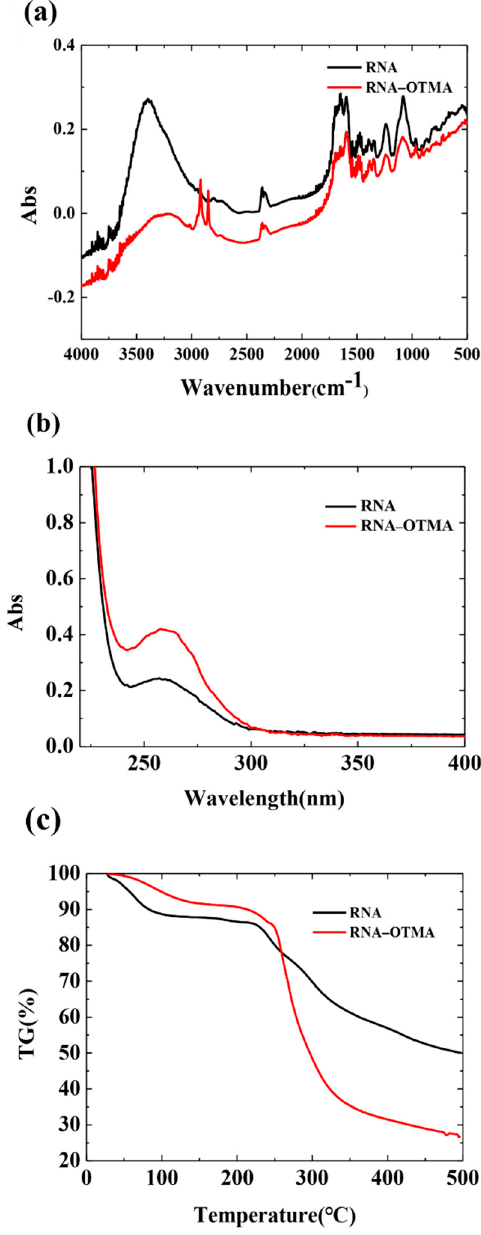
Figure 4. ( a ) Fourier transform infrared (FTIR) spectra, ( b ) UV absorption spectra in butanol solution and ( c ) TG curves of RNA and RNA–OTMA.